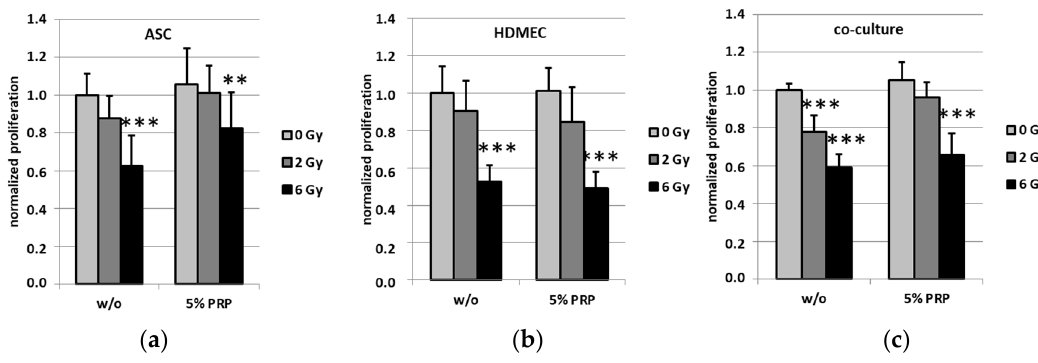
Figure 3. Cell proliferation of ASC, HDMEC and the corresponding co-culture upon treatment with PRP was determined using a BrdU assay. Error bars represent standard deviation. Values are represented as means ± standard deviations. Statistical significances of * p ≤ 0.05, ** p ≤ 0.01 and *** p ≤ 0.001 are indicated, respectively.